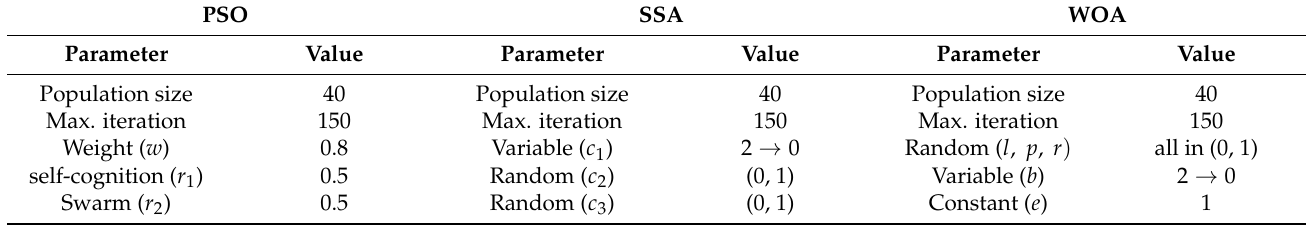
Table 7. Parameter settings for every optimization algorithm.